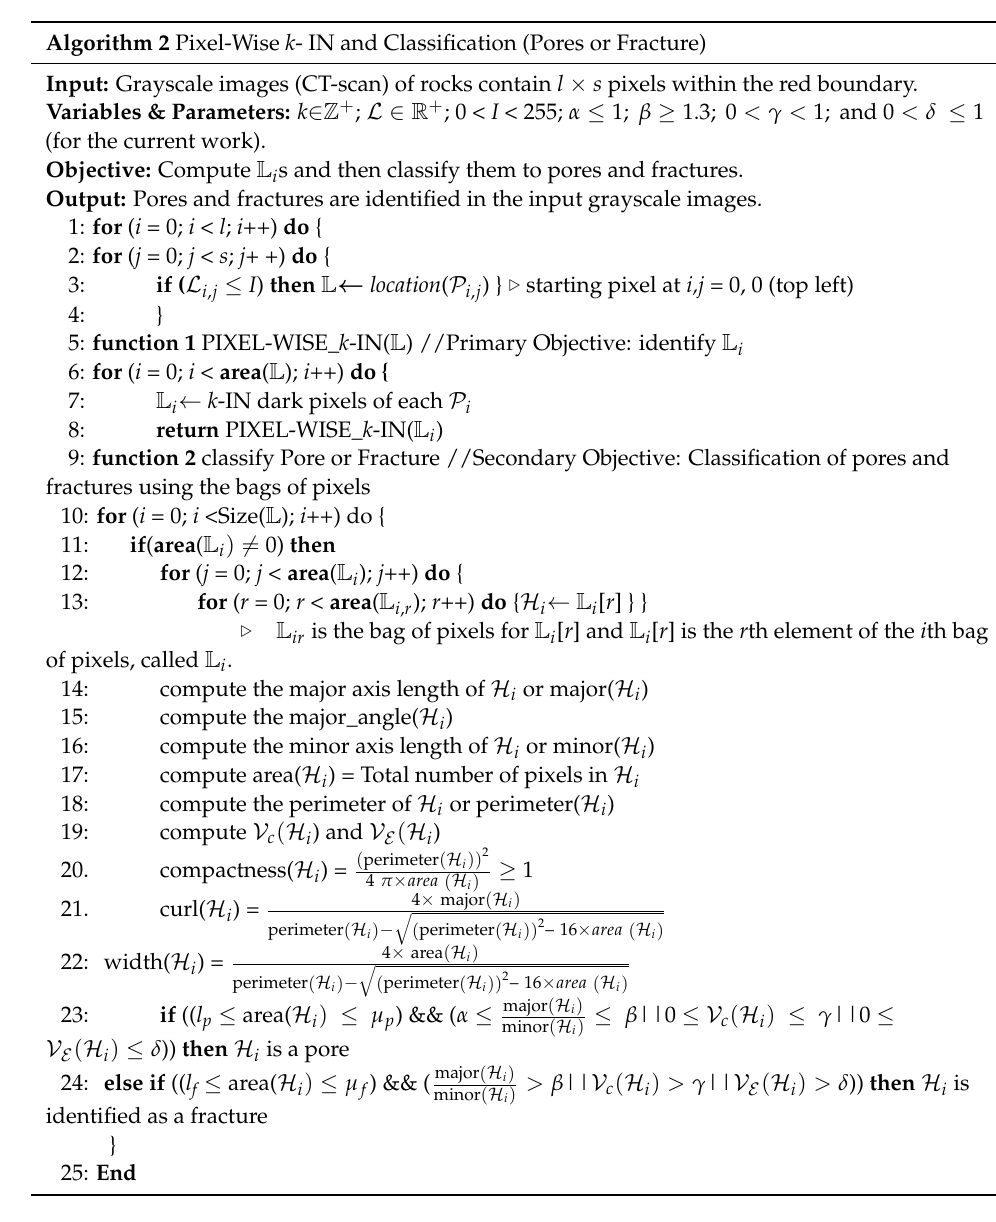
Figure 1. ( a ). Step ‐ wise procedure to find k ‐ INs of any pixels. area ( ℋ 𝑖 ), major ( ℋ 𝑖 ), minor ( ℋ 𝑖 ), pe ‐ Algorithm 2 Pixel-Wise k - IN and Classification (Pores or Fracture) rimeter ( ℋ 𝑖 ) and curl ( ℋ 𝑖 ) of a fracture and pore are shown in ( b ) and ( c ), respectively. Quite evi ‐